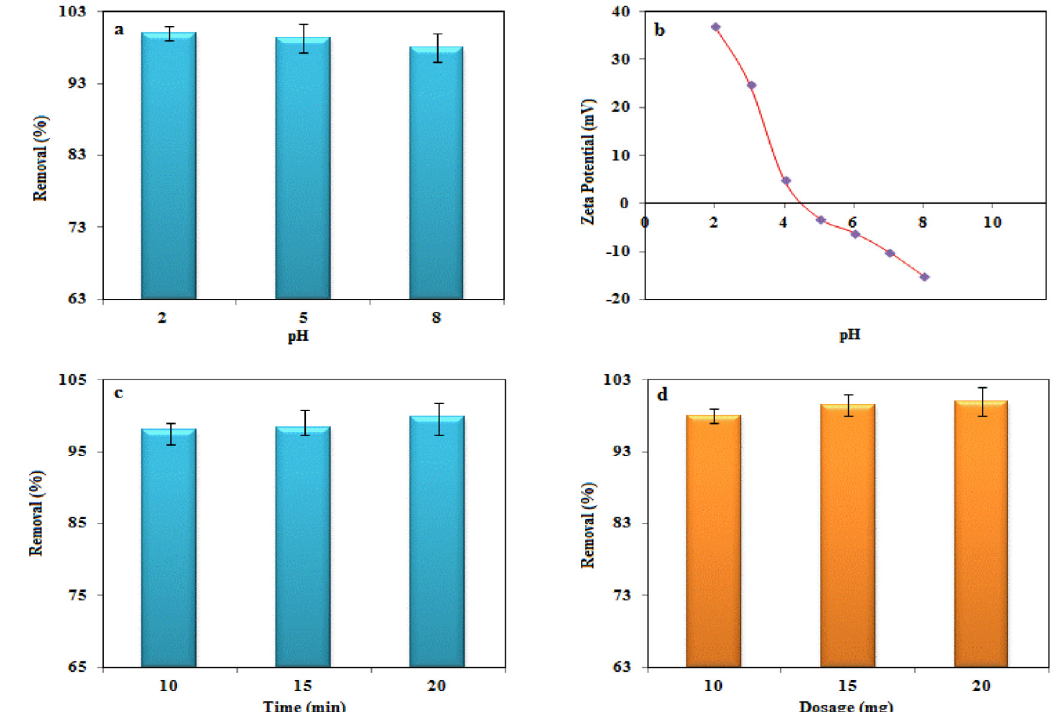
Fig.3. Effect of pH (a) on bacterial capturing efficiency (dosage 20 mg, time 30 min, volume 10 mL, n=3). Data of zeta potential mea- surements (b) for polymer composite. Effect of time (c) on bacteria capturing (pH = 8, dosage 20 mg, volume 10 mL, n=3). Effect of dosage (d) on bacteria capturing (pH = 8, time 20 min, volume 10 mL,